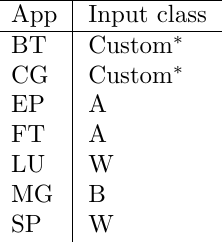
Table 4: The SNU-NPB applications targeted and the testcase used for evalua- tion. ∗ Custom input classes defined in